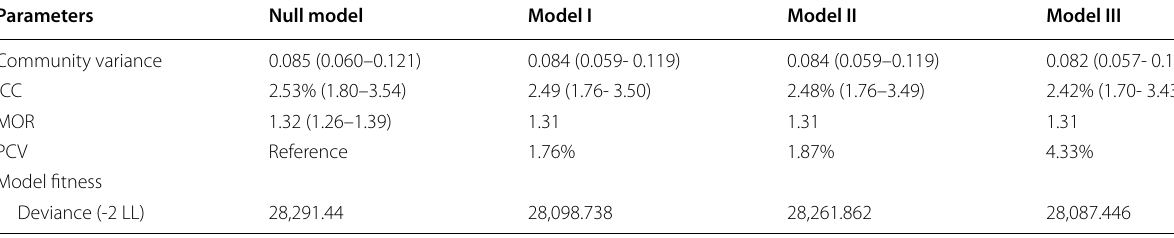
Table 2 Result of model comparison and random-effects analysis Parameters